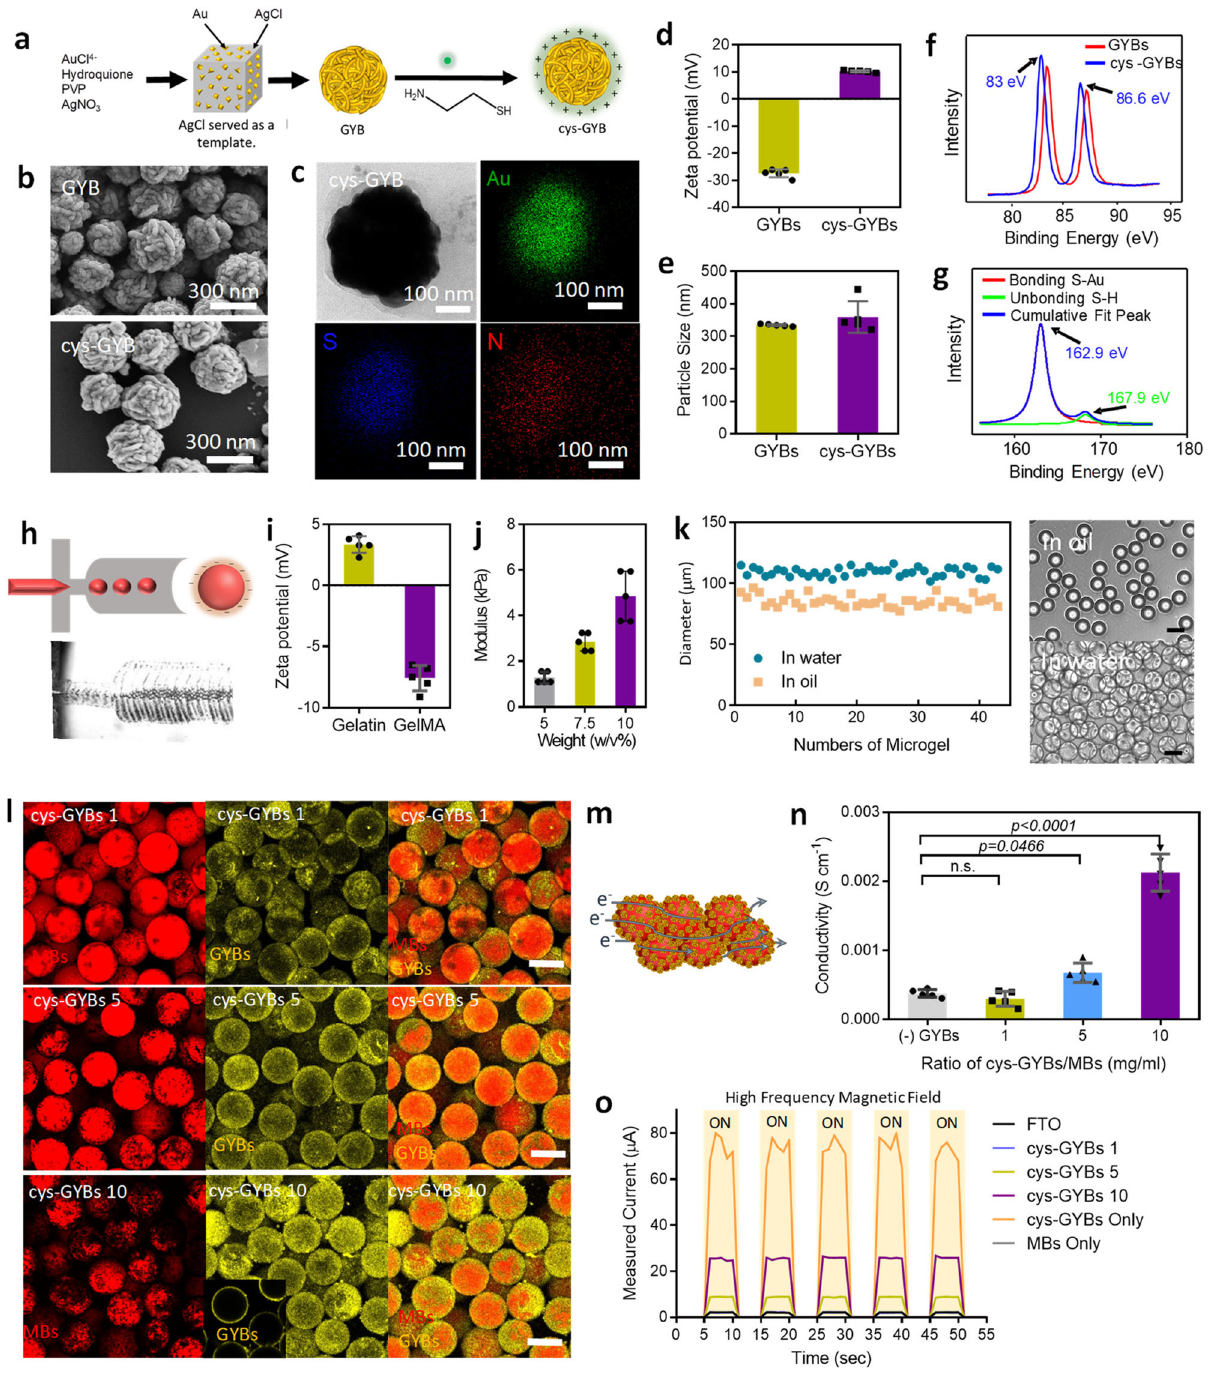
Fig. 2 | Preparation and characterization of conductive microporous hydrogel (CMH). a Schematic illustration of synthesis of cys-GYBs. b Scanning electron microscopy (SEM) images of GYBs and cys-GYBs. c TEM images of cys-GYBs and distribution of the elemental mapping of Au, S and N. d – e The surface charge of GYBs and cys-GYBs and zeta-potential measurements. Error barsrepresent mean± s.d., n = 5. HRXPS analysis of GYBs and cys-GYBs via ( f ) Au4f signal and ( g ) S2p signal. h Microscope image of the device generating GelMA droplets. i Zeta potential of gelatin and GelMA. Error bars represent mean ± s.d., n = 5.